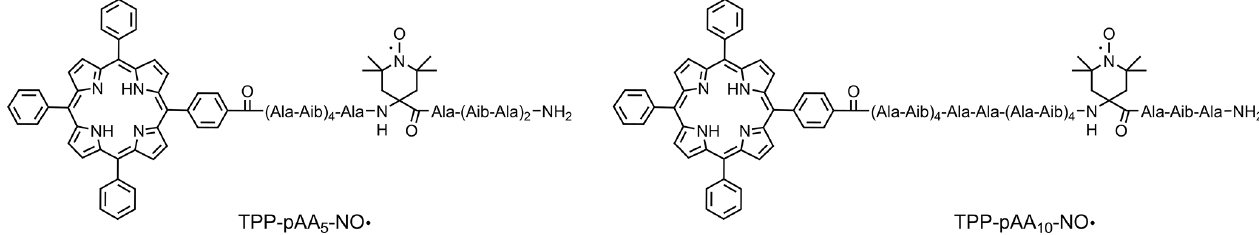
(cid:113) (cid:113) and TPP–pAA 10 –NO , where the letter code “Ala” denotes L -alanine, and